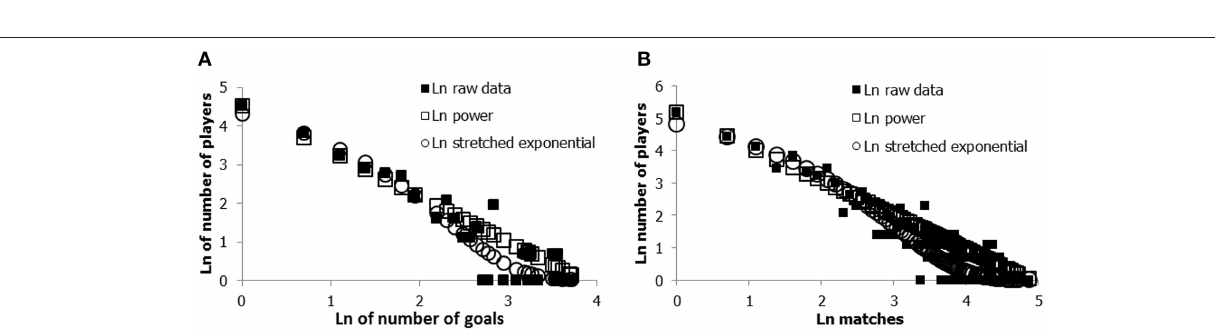
FIGURE 2 | Log-log representation of the frequency and number of goals (A), and matches played in international matches for the Dutch national soccer team (B), with fitted power law and the stretched exponential models. Number of goals: Power parameter p = 1.18; stretched exponential β = 0.6; Number of matches: p = 1.05; β =